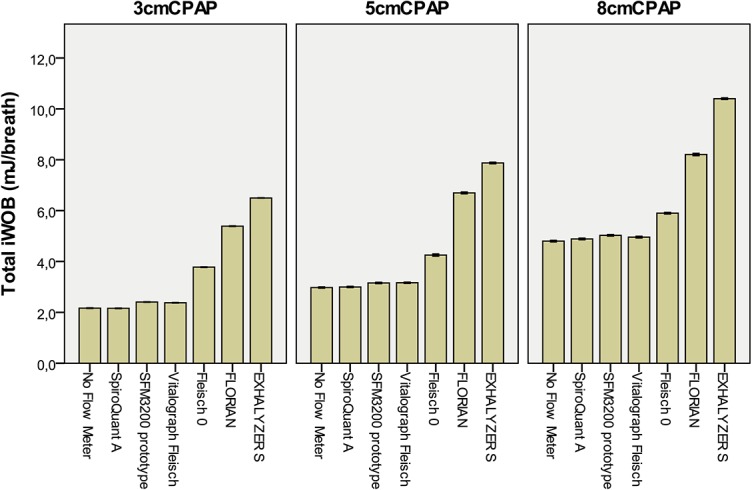
Imposed WOB for Infant Flow with flow meters.Simulations using flow-through measurement at three levels of CPAP for simulated breathing with 32 ml tidal volume. Bars show mean imposed WOB (Total iWOB) for twenty consecutive breaths with 95% CI.